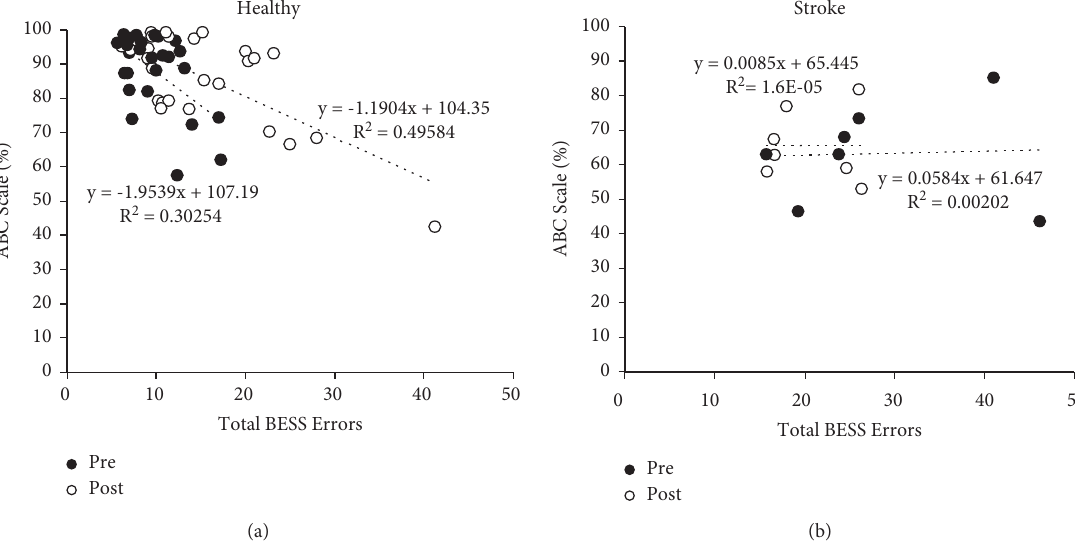
y = -1.1904x + 104.35 R 2 = 0.49584